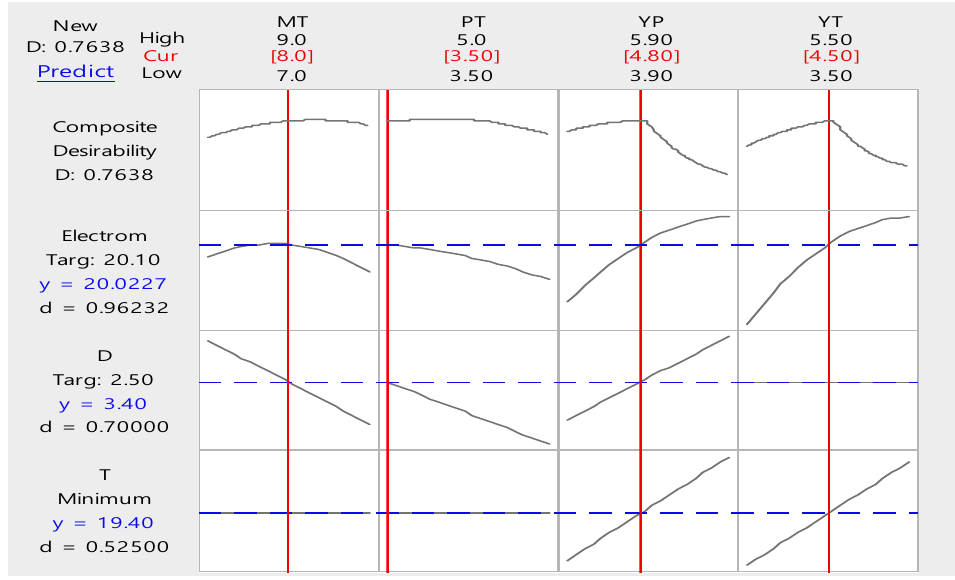
Figure 10. Desirability chart of design variables for optimization to minimize volume.